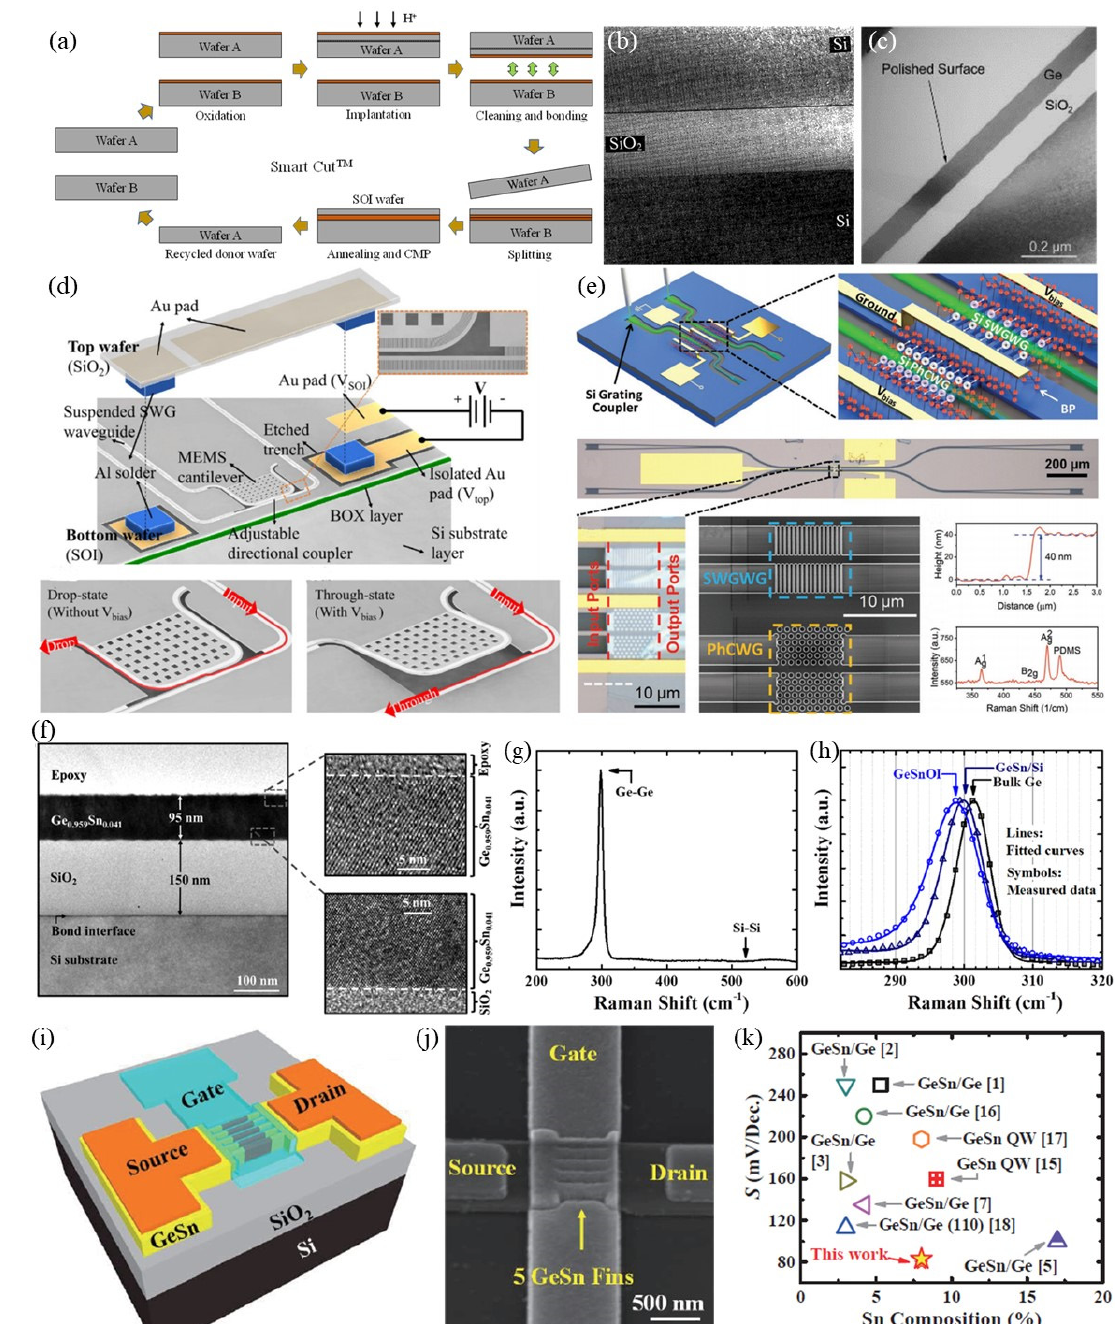
Figure 2. Smart Cut TM process for the fabrication of SOI, GeOI, and GeSnOI, as well as their applications in photonics and electronics. ( a ) Flow chart of the Smart Cut TM process for the thin-film transfer. ( b ) TEM image of the transferred SOI interface [34]. ( c ) Transferred GeOI interface observed by TEM [40]. ( d ) A typical application of SOI in MEMS-based tunable waveguide coupler [53]. ( e ) A traditional application of SOI wafer in MIR slow light waveguide photodetector [54]. ( f ) Interfacial characterization for the GeSnOI wafer fabricated by the direct bonding method [55]. ( g ) Interface studies for the bonded GeSnOI wafer [55]. ( h ) Strain calculation for the GeSnOI wafer based on the comparison of Raman spectra